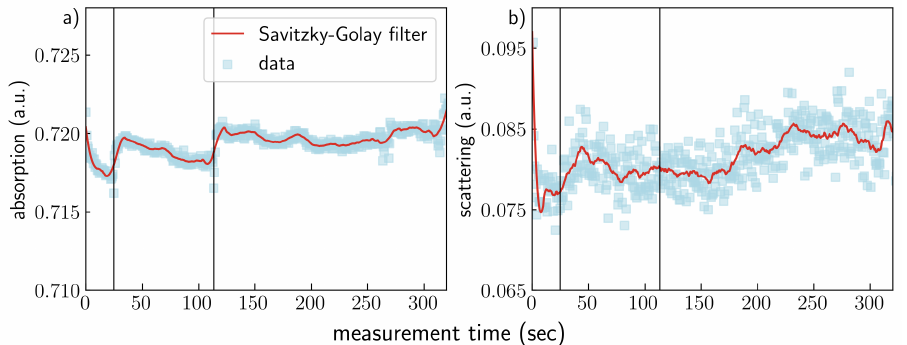
Figure 8. Evolution of the absorption ( a ) and scattering ( b ) contrast signals over the 320 s of measurement time. The data points represent the mean value of the signal in ROI indicated in Figure 1, and the red line is the result of data filtering with the Savitzky–Golay filter with a third- degree polynomial and a window of 21 data points. The gray and black vertical lines indicate the 25th and 113th seconds,